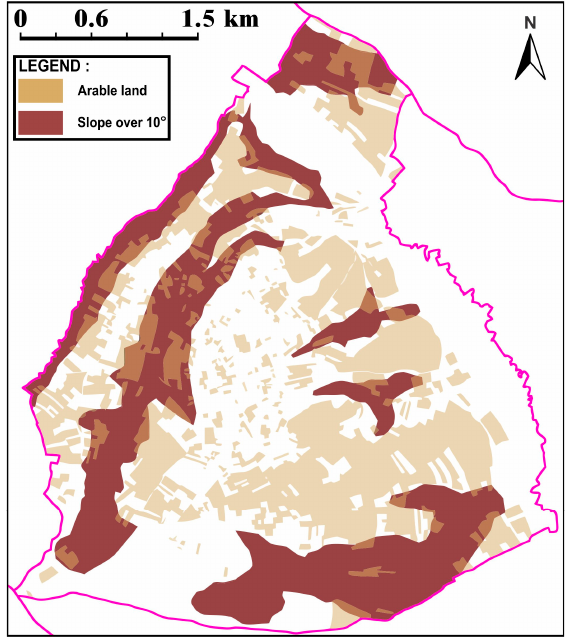
Figure 4. Example of the overlapping of the map of land use and the slope map for erosion mapping, for the settlement of Zuce for the year 2018.